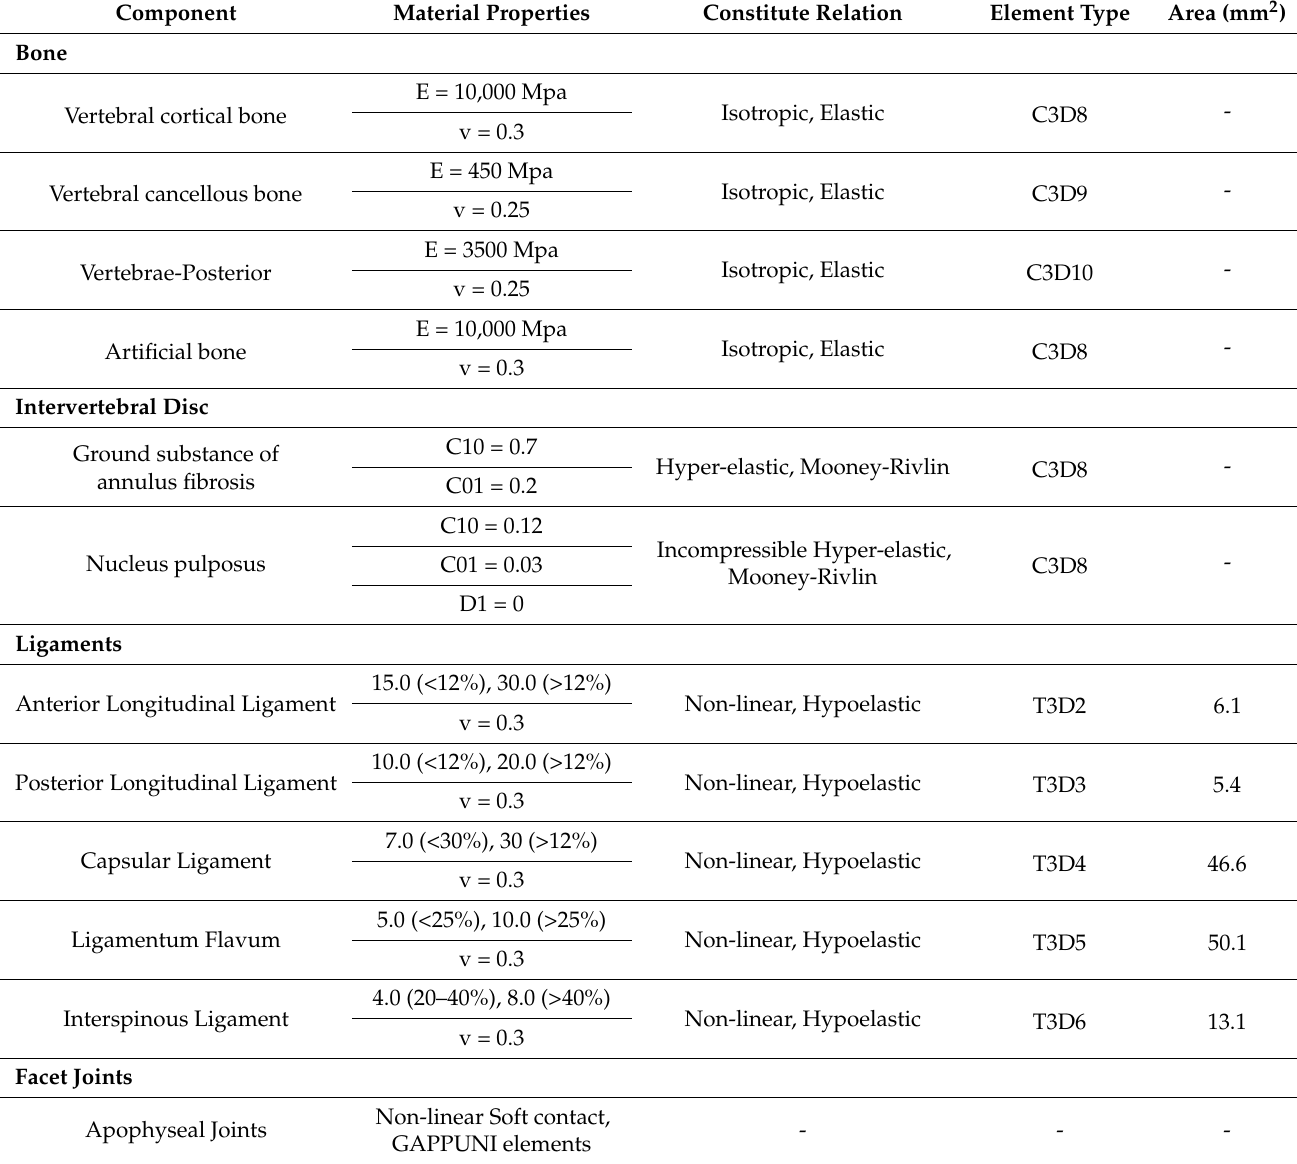
Table 1. Material properties assigned to the finite element model